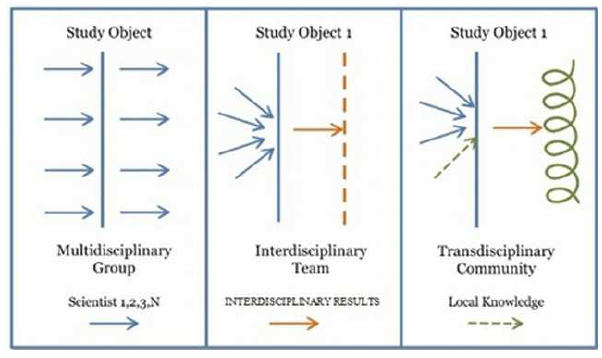
Fig. 2. Comparison among three types of multidisciplinary studies (taken from I. Espejel